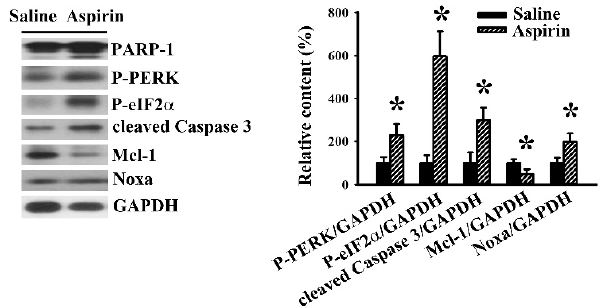
Figure 7. Aspirin induced apoptosis in tumor tissues. U87 cells were subcutaneously implanted into BALB/c nude mice. One week after implantation, aspirin (50 mg/kg) and saline vehicle were administrated daily via oral gavage for three weeks. Proteins were extracted from the dissected tumor tissues and subjected to Western blot with indicated antibodies. * p < 0.05 vs. saline, n = 6.